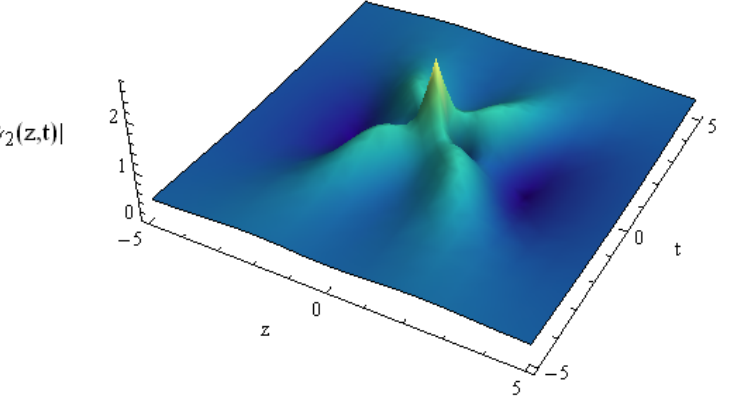
Figure 14. Change of solution (22) with z , t for c = 0.5, v = 0.7, β 1 = 0.1, β 2 = 1, β 3 = 0, β 4 = 0.